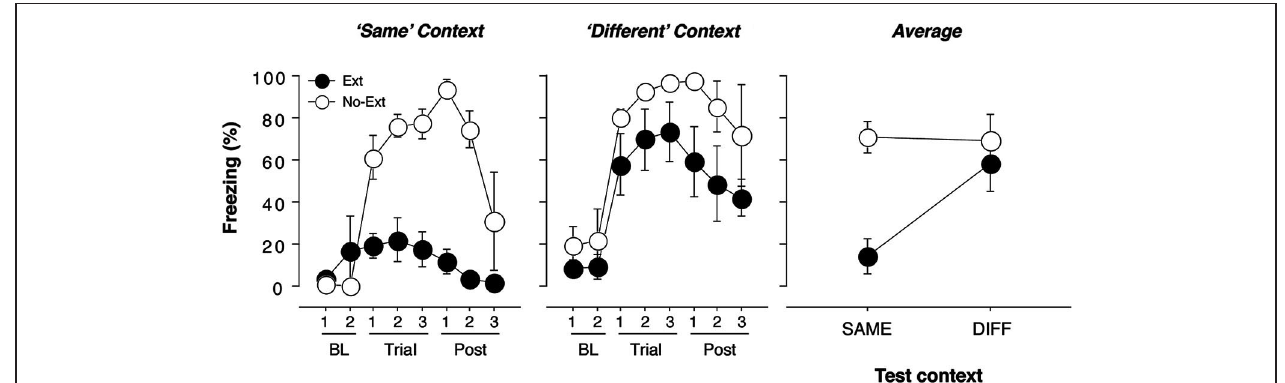
FIGURE 1 | Freezing behavior in extinguished and non-extinguished rats during the test sessions . Rats were fear conditioned in Context A on Day 1 and subsequently underwent context exposure and extinction in Context C and Context B (contexts were counterbalanced) on Day 2. During the retrieval test on Day 3, rats were tested twice: once in the extinction context and once outside the extinction context, with each test separated by an 18-min interval. Each test consisted of three tone-alone presentations with 30 s ISIs. Immediately after the second test, rats were sacrificed and brains were extracted for catFISH processing. Freezing behavior during conditioning and extinction was typical and did not differ from previous reports (Orsini et al., 2011); thus, it is not displayed. (A) Mean percentage of freezing ( ± SEM) to the CS when presented within the extinction context (“Same”). Freezing was